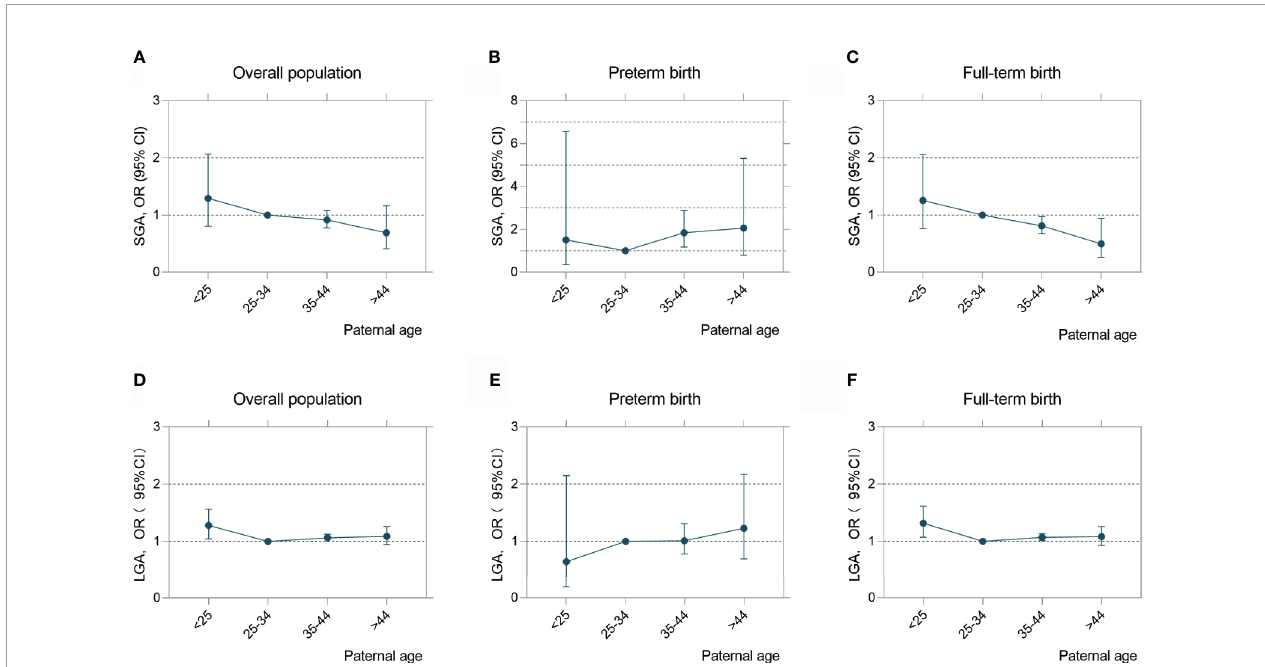
FIGURE 3 | Paternal age exerted an opposite effect on birthweight among preterm and term infants. Adjusted odds ratios (ORs) and 95% con fi dence intervals for risks of SGA (A – C) and LGA (D – F) according to paternal age in overall population, preterm birth and full-term birth infants. Analyses were adjusted for maternal age, BMI, ethnicity, education level and marital